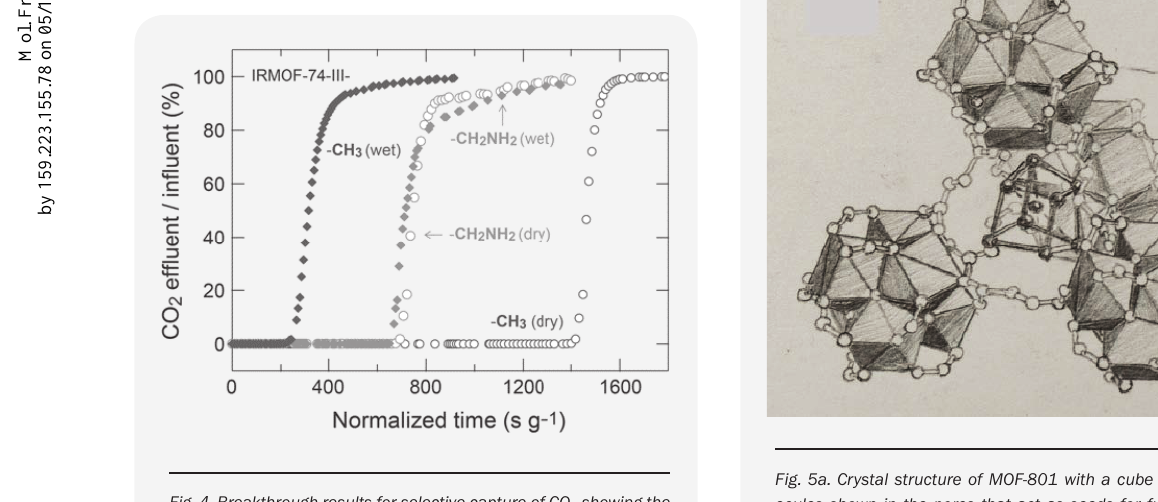
Fig. 4. Breakthrough results for selective capture of CO 2 showing the separation of CO 2 and from water.